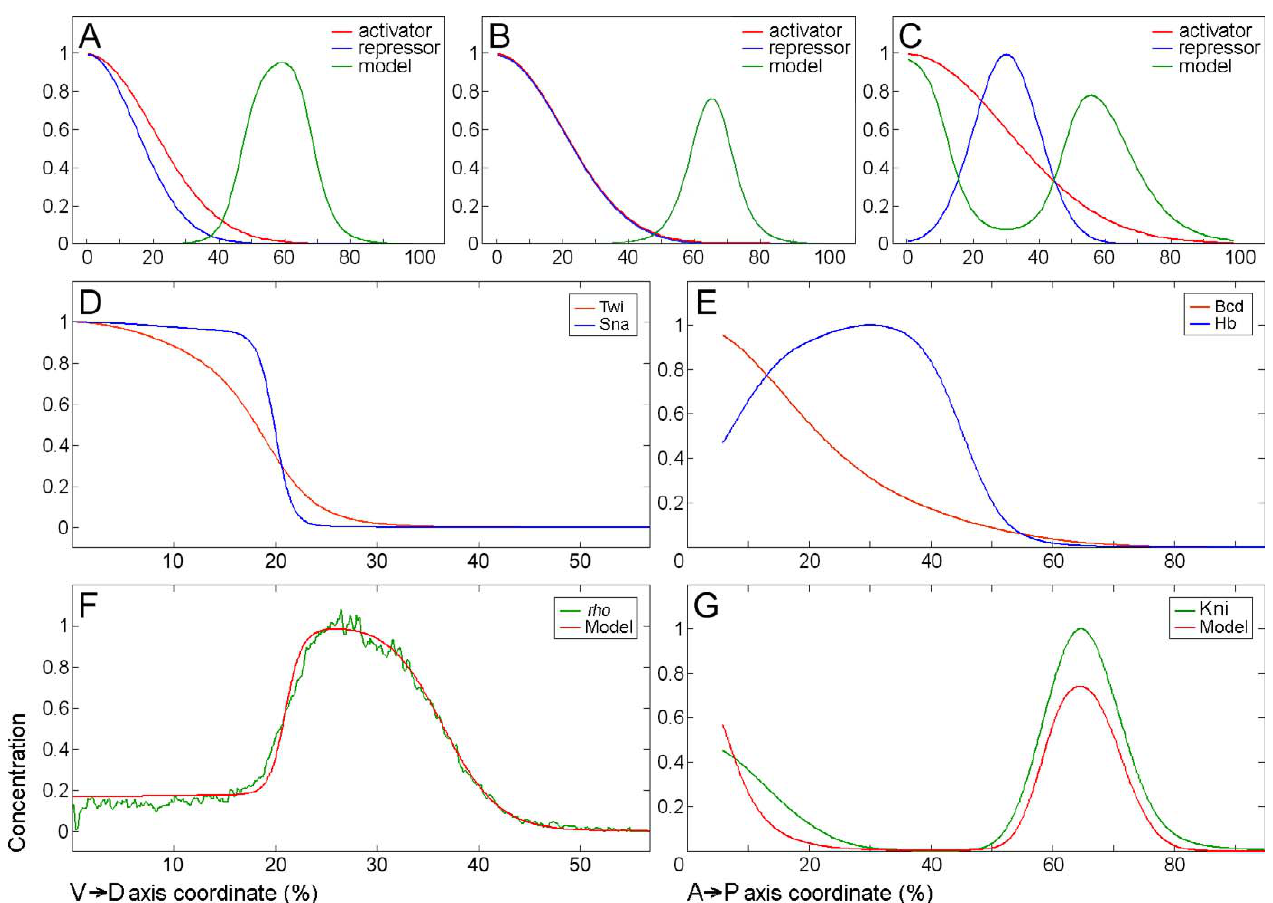
Figure 2. Outcomes of Two Antagonistic Gradients (A–C) Possible spatial distributions of activator (red), repressor (blue), and the corresponding predicted responses (green). Input gradients here were approximated as Gaussian functions (see other functions in Figure S2). (A) The activator has a slightly wider expression domain. (B) The activator and the repressor have identical distributions. (C) The peak of the repressor gradient is shifted relatively to the peak of the activator; expression of the downstream gene is ‘‘ split ’’ into two domains. (D) Spatial patterns of Twist (red) and Snail (blue). (E) Spatial patterns of Bicoid (red) and Hunchback (blue). (F) Spatial pattern of rho (green) and the rho model (in red). (G) Spatial pattern of Knirps (green) and a knirps model (red).